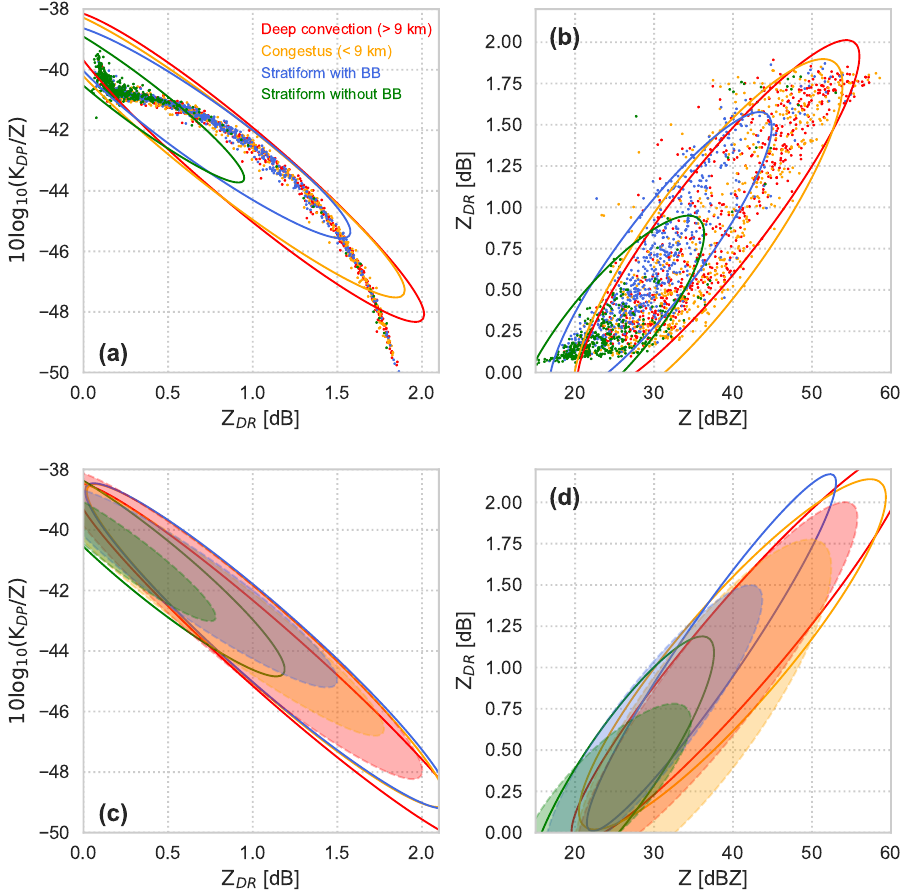
Figure 12. Scatter plots of Z DR versus 10log 10 ( K DP /Z ) and Z versus Z DR for the various regimes, deep convection, congestus, stratiform with bright band and stratiform without bright band identified by the RWP classifications (a, b) . The ellipses convey the two-sigma confidence interval for corresponding regimes. The wet (shaded ellipses) and dry (ellipses) season segregations are presented in (c, d)